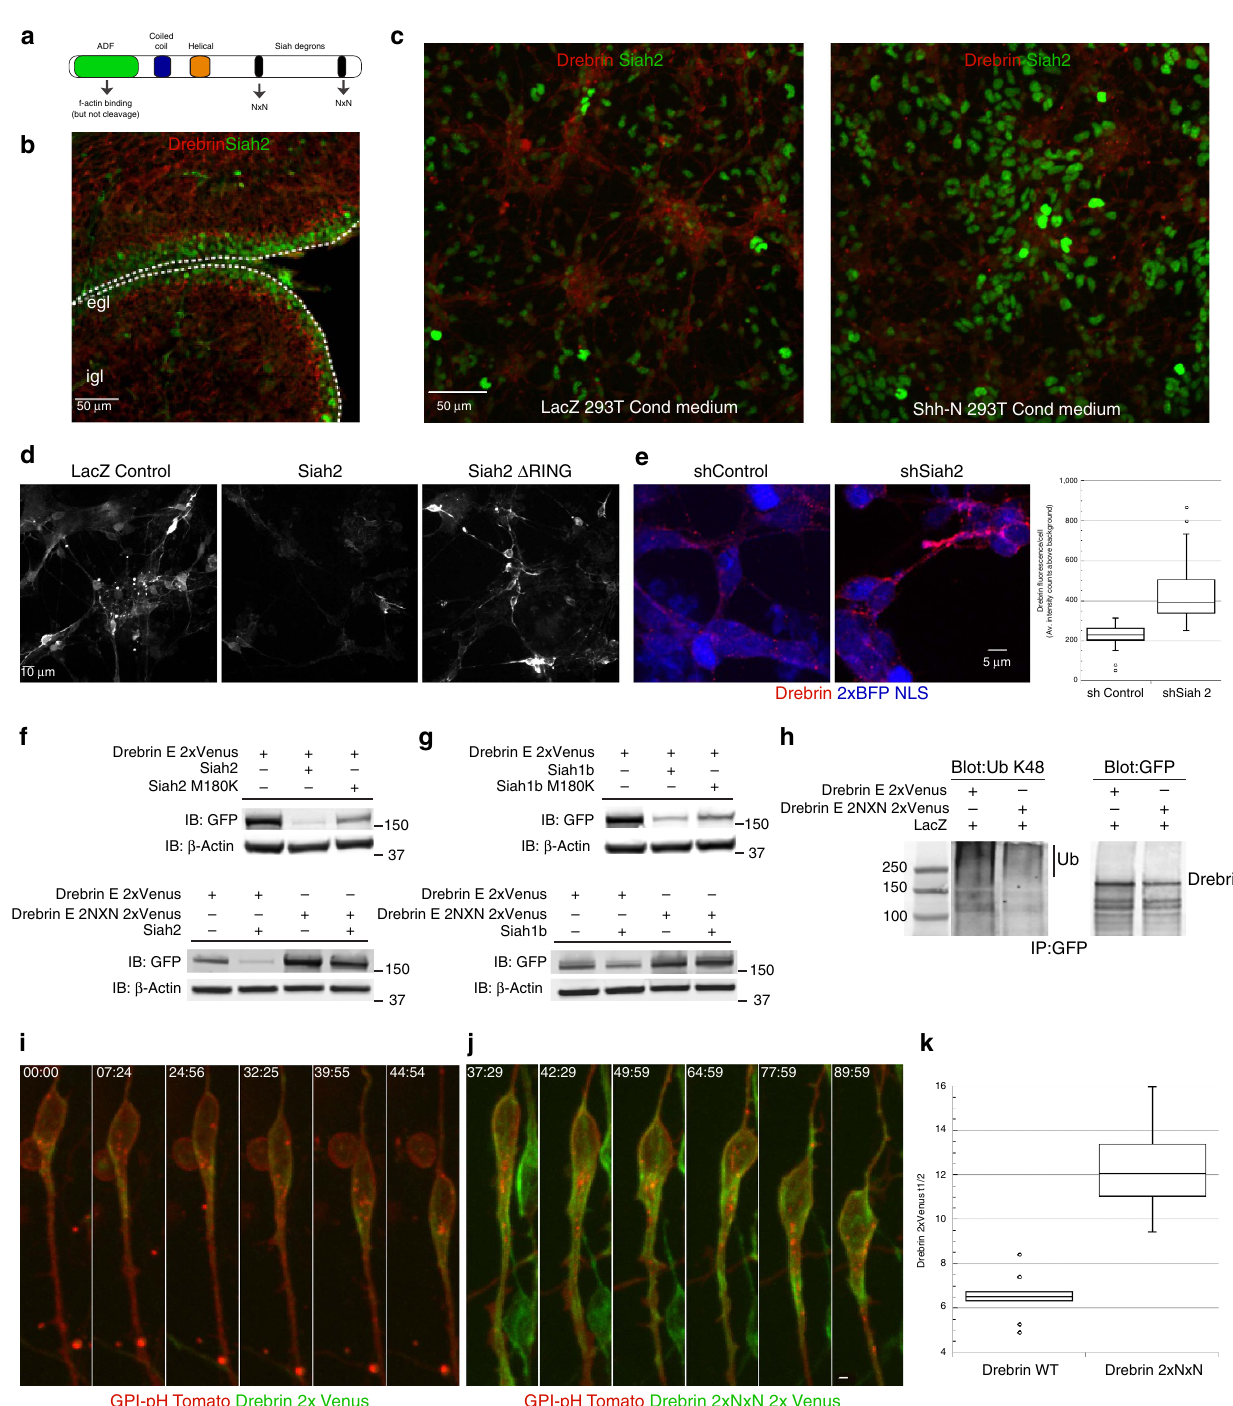
NATURE COMMUNICATIONS|8:14484|DOI: